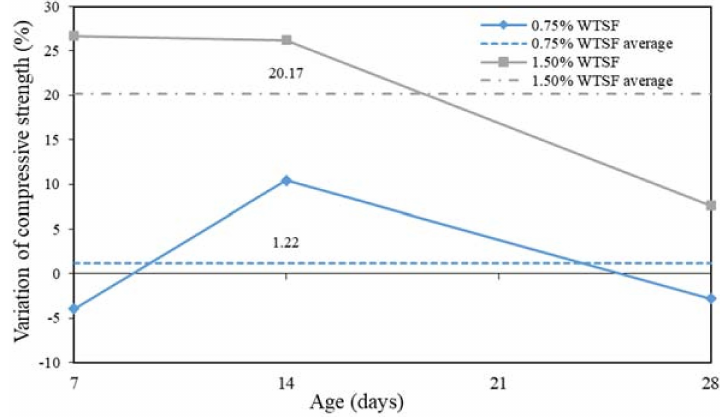
Figure 10. Percentage of variation in compressive